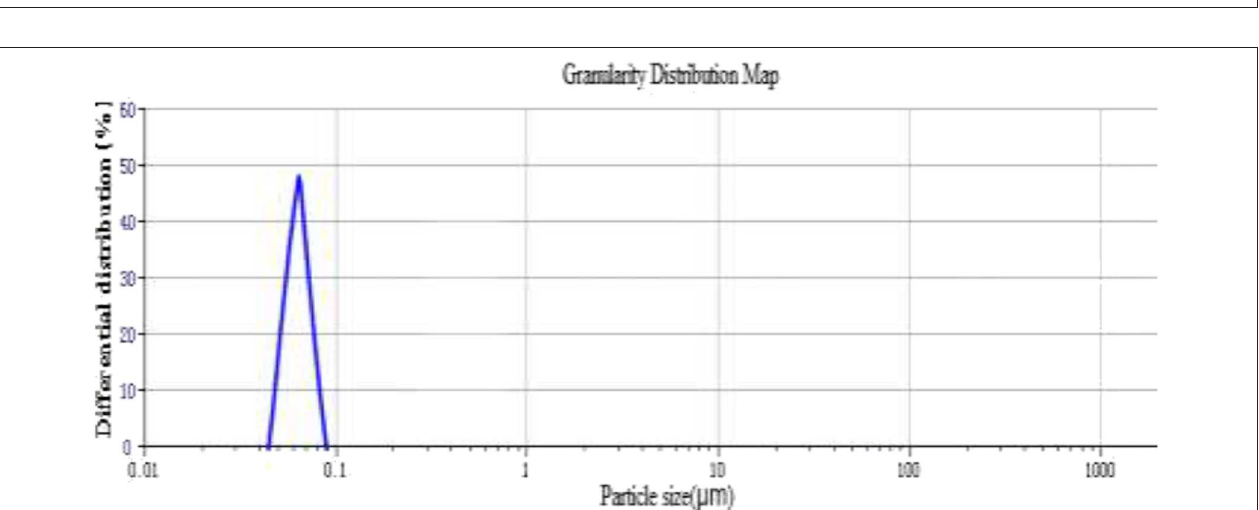
FIGURE 4 | Magnetization force curves for Fe 3 O 4 @SiO 2 amphiphilic asymmetric Janus nanosheets (25 ◦ C).